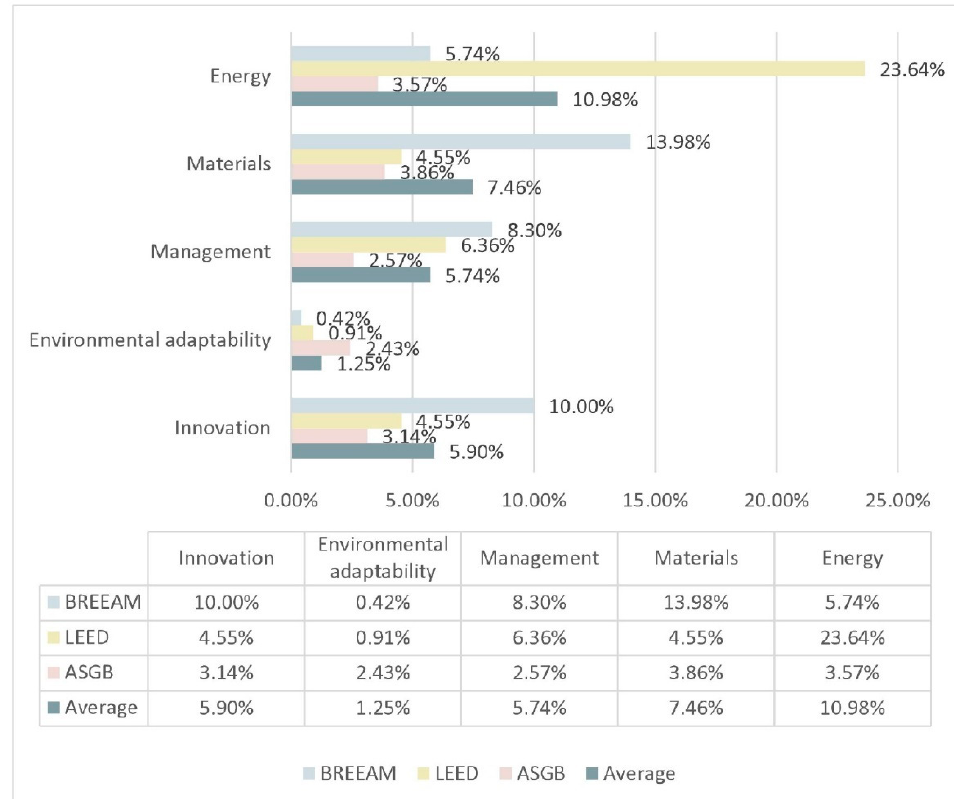
Figure 3. Analysis of scope weights.